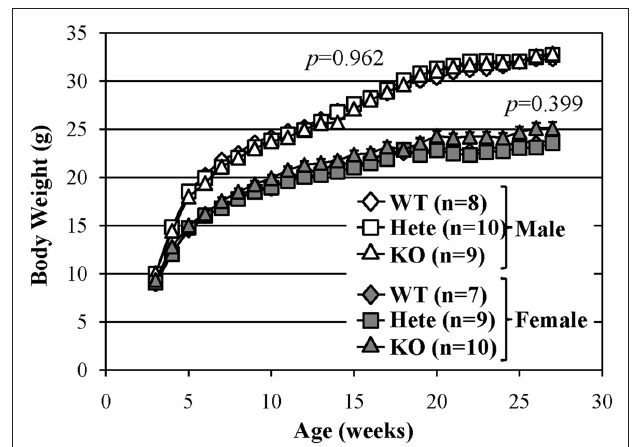
Figure 2 | Normal growth of relaxin-3 KO mice. The body weight in the wild-type (WT), heterozygote (Hete), or KO male and female mice was measured during postnatal development. Body weight is presented as mean ± SEM. Data were analyzed with repeated measures ANOVA. p -Values indicate significance of genotype effect.